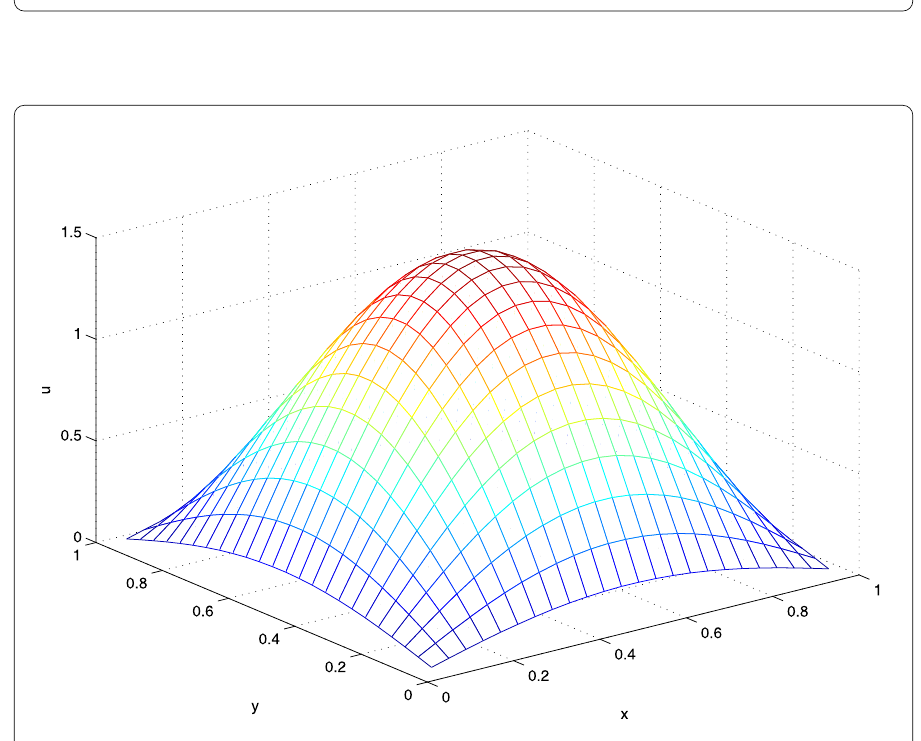
Figure 3 The numerical solutions for r = 1.0, h = 1/25 at t = 0.4